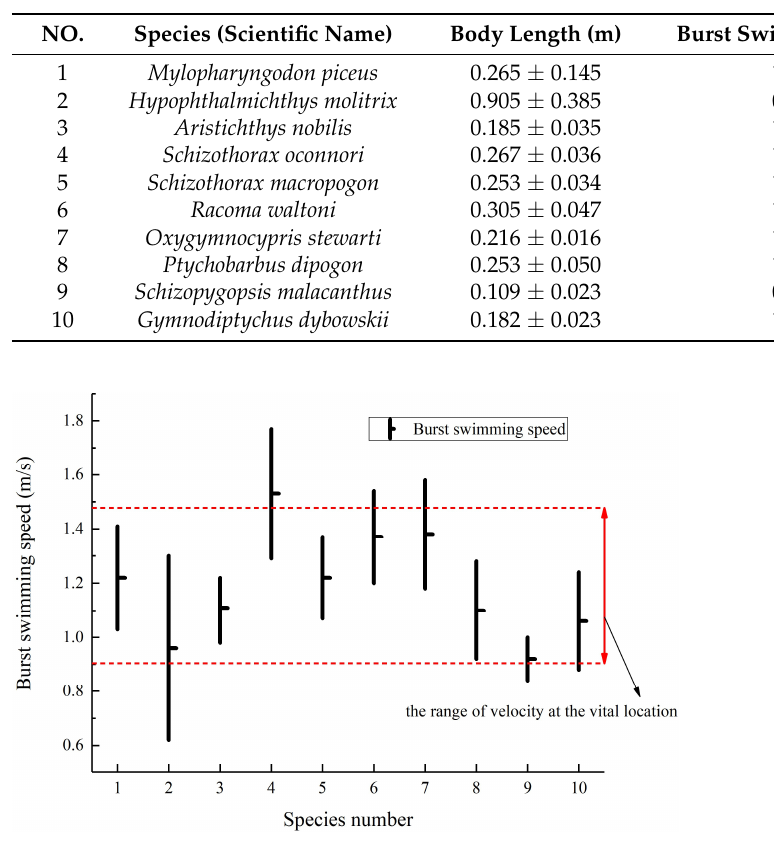
Figure 10. The burst swimming speed of different fish species .